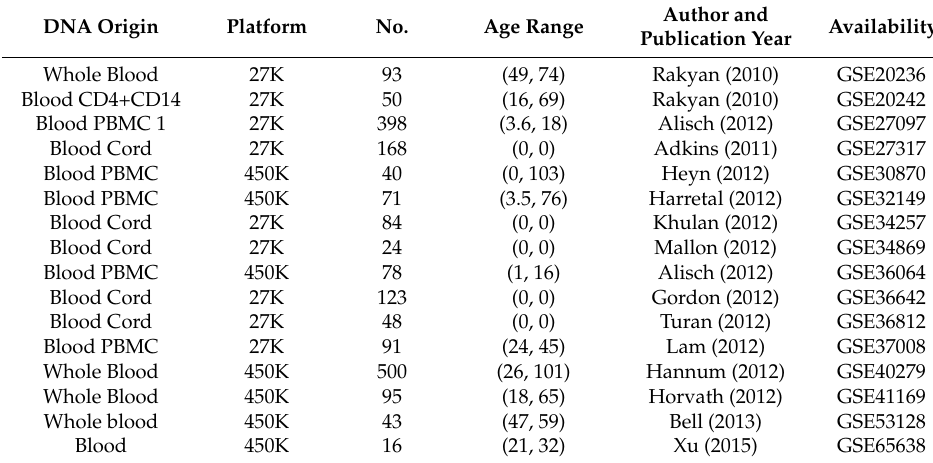
Table 1. Sixteen healthy DNA-methylation datasets.